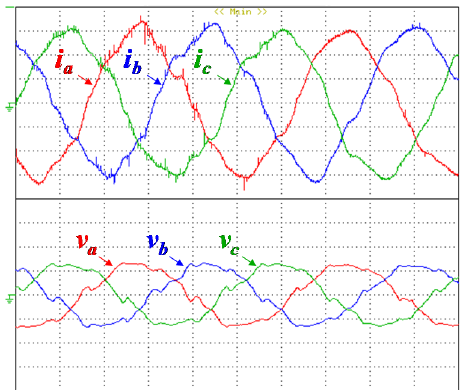
Figure 31. Three-phase currents and voltages when the electric machine operates with a 45 Nm mechanical load (current: 20 A/div; voltage: 20 V/div; time: 10 ms/div).